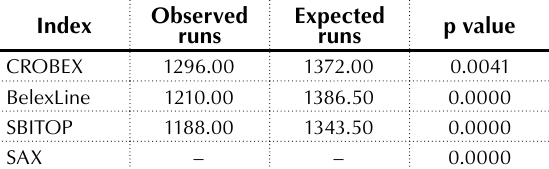
Table 3. Runs test results